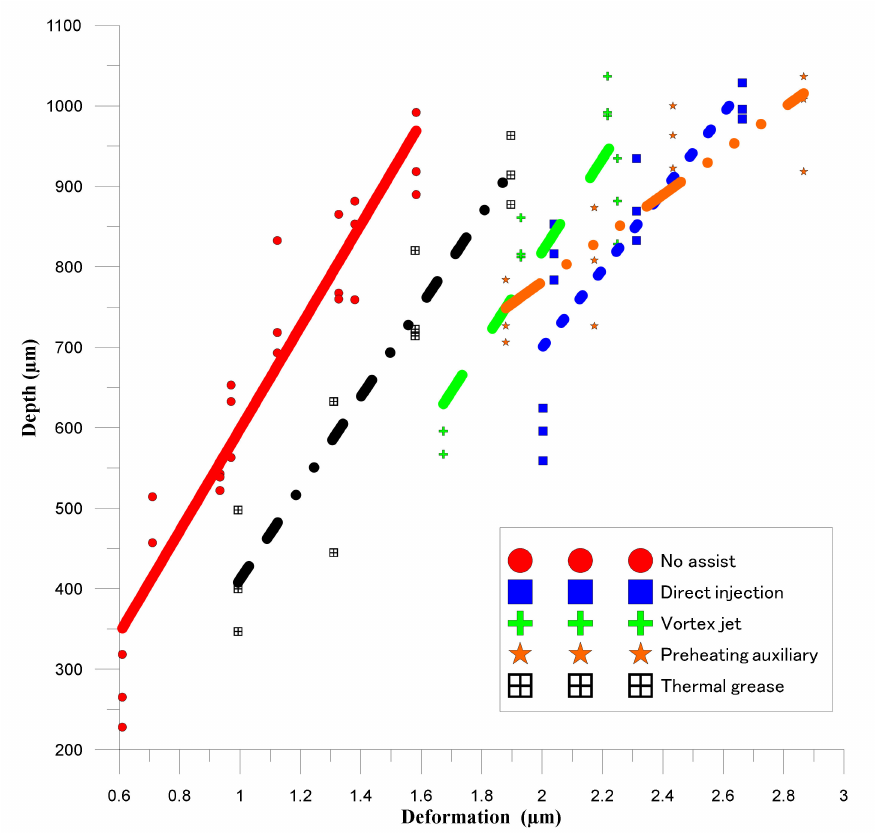
Figure 10. Relationship between hole deformation and hole depth in laser processing with five auxiliary mechanisms.